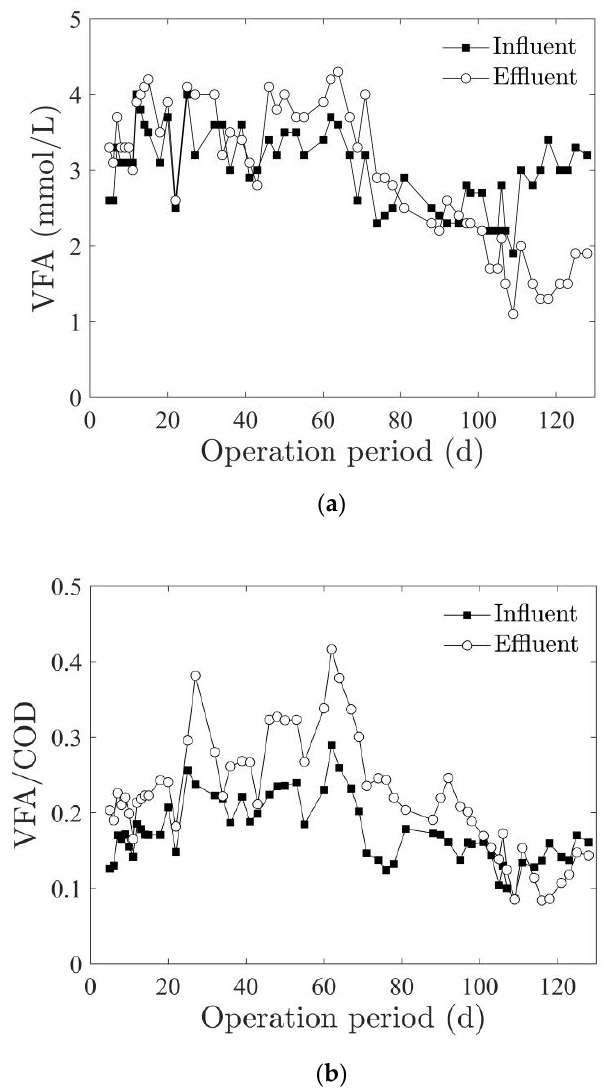
Figure 2. Variation of the ( a ) VFA concentration and ( b ) ratio of VFA to COD in the influent and effluent wastewater during the ABR operation period.